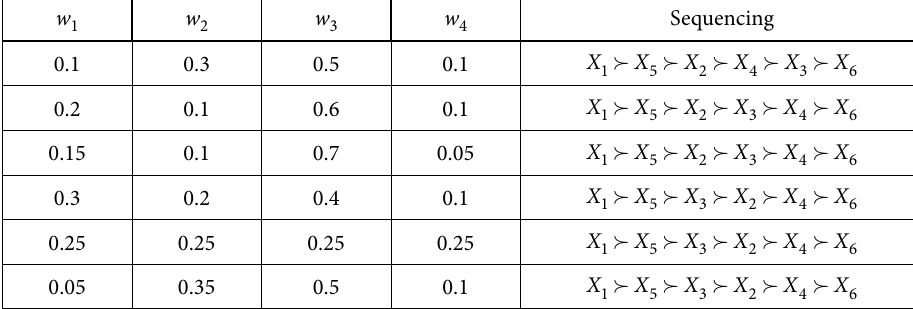
Table 17. The sequencing for different values of subjective weight w w 1 w 2 w 3 w 4 Sequencing 0.1 0.3 0.5 0.1 0.2 0.1